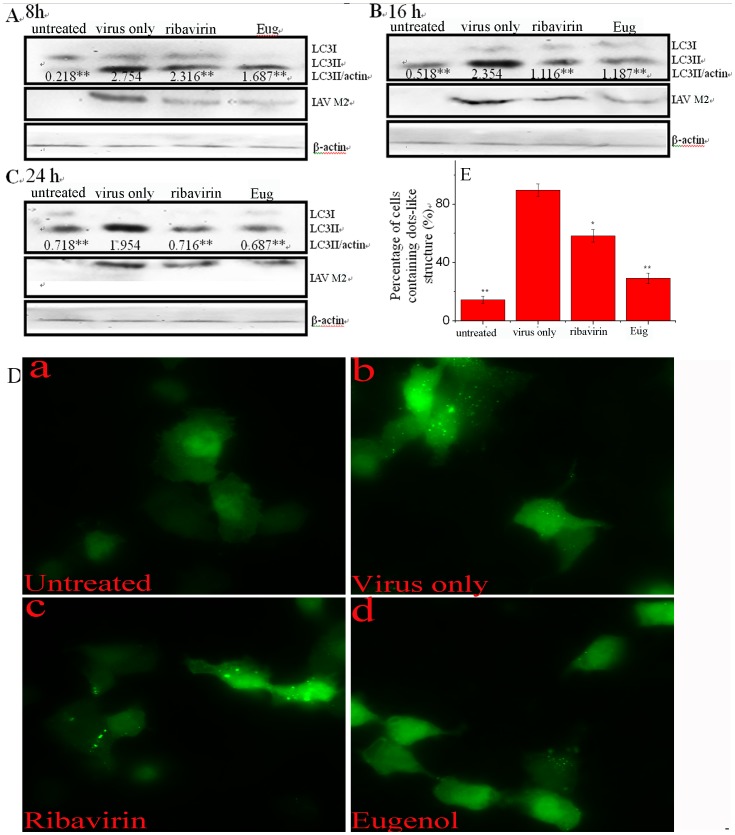
Eugenol inhibited the elevated autophagy after IAV infection (A/ShanTou/169/06 (H1N1)).(A, B and C) Eugenol inhibited the conversion of LC3I to LC3II determined by western blot. In the untreated group, A549 cells were not infected with IAV. In the virus only treated group, A549 cells were infected but not treated with any drugs. In the ribavirin and Eug treated groups, A549 cells were infected and treated with ribavirin (25 µg/ml) and eugenol (5 µg/mL), respectively. MOI = 0.001, the incubation times were 8, 16 and 24 h, respectively. The ratios of LC3-II to β-actin were presented below the blots. At each time point, we also determined the level of IAV M2 protein of each group. (D) Eugenol inhibited the accumulation of autophagosomes determined by EGFP-LC3 assay. In untreated, virus only, ribavirin and Eug groups, A549 cells were transfected with the pEGFP-LC3 plasmid, then performed as above western blot assay, but MOI = 2.0, the incubation time was 8 h. The percentage of cells containing EGFP-LC3 dots to cells expressing EGFP was calculated in 10 fields chosen at random (E). The graphs were obtained from an inverted fluorescence microscope (10×40). Data shown were the mean ± SD of three independent experiments. *P<0.05 and **P<0.01 vs. NC.